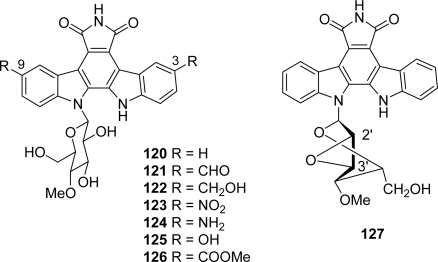
Indolocarbazole analogues substituted in 3,9-positions and 2’,3’-epoxyderivative 127.